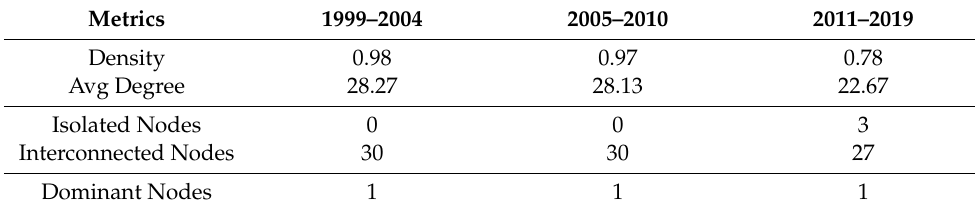
Table 4. Network metrics for 0.8 threshold level on the HICP